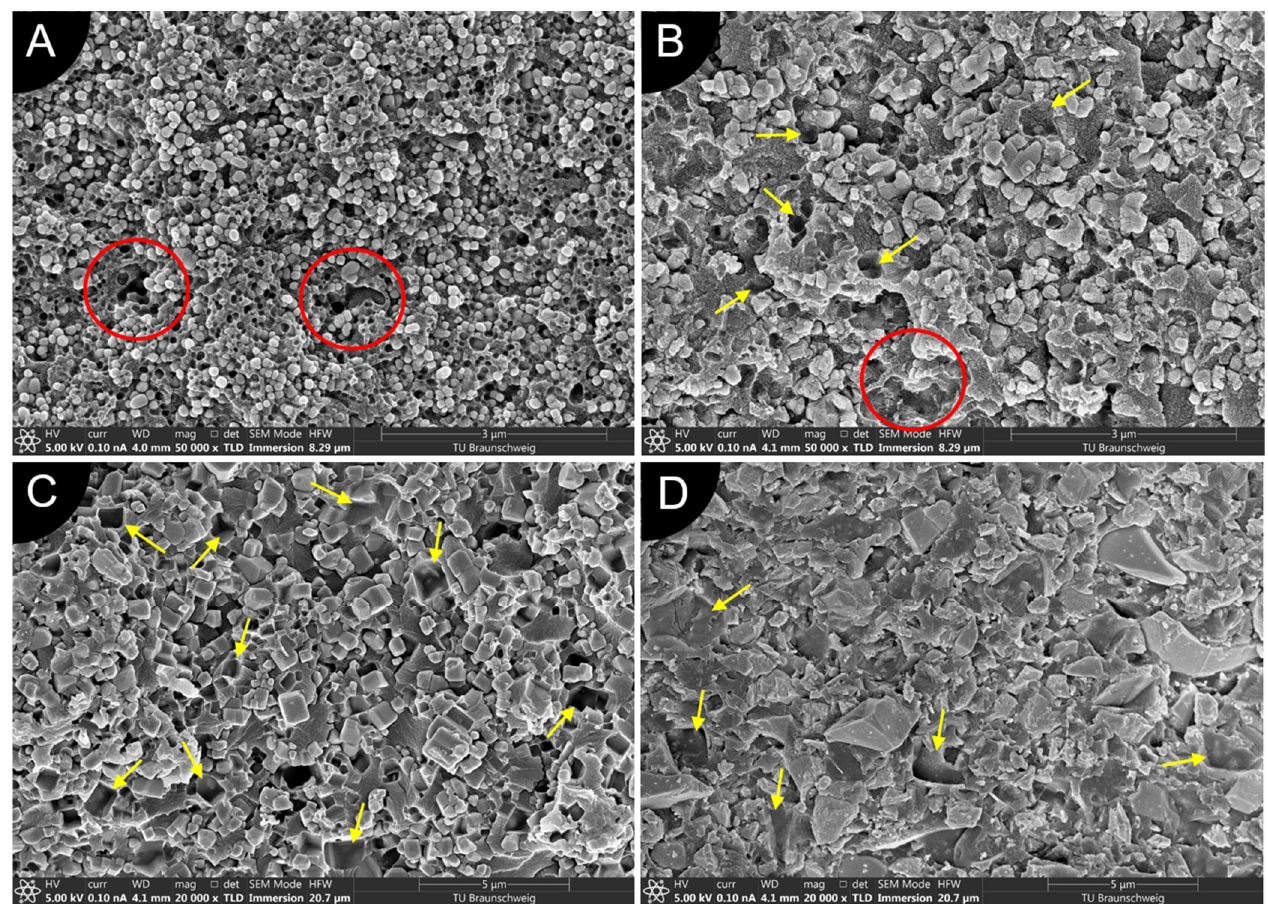
Figure 9. SEM images of cross-sections of solidified piezoelectric composites made with 30 vol.% of ( A ) BTO (magnification ×50,000), ( B ) KNN7 (magnification ×50,000), ( C ) KNN3.5 (magnification ×20,000), or ( D ) PZT (magnification ×20,000). Red circles show voids without particles and yellow arrows indicate places of missing particles dropped during composite breakage.